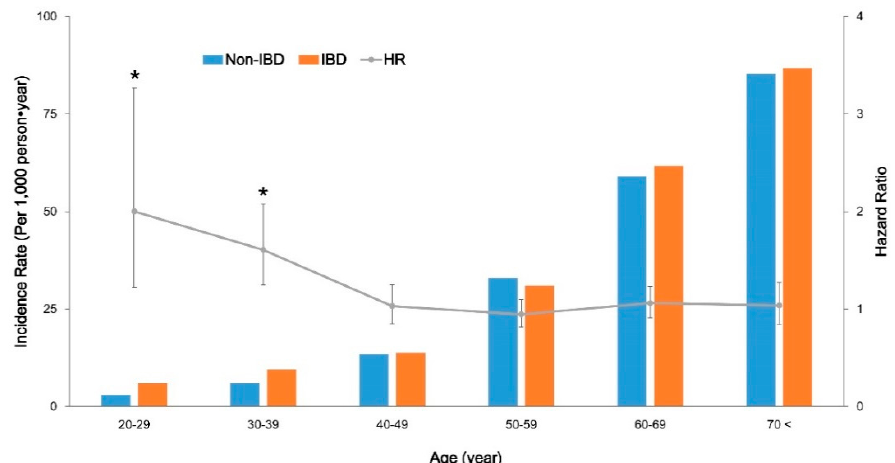
(UC) compared with age-matched non-IBD (inflammatory bowel disease) controls based on age group. Patients with CD (red line), UC (green line), and non-IBD controls (black line). All ages ( A ), under 40 years ( B ), over 40 years ( C ). CD, Crohn’s disease; IBD, inflammatory bowel disease; UC, ulcerative colitis.